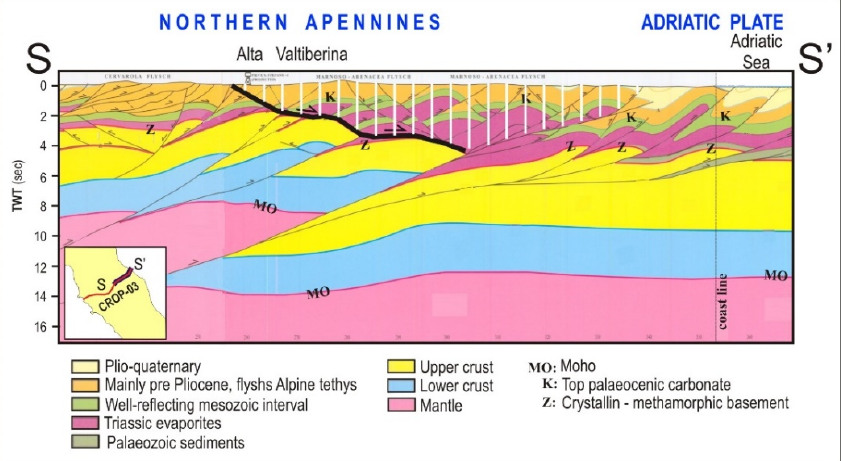
Figure 13. Eastern sector (see inset) of the CROP-03 cross-section ([41,112] modified). The white vertical strips evidence the RMU sedimentary wedge, which is decoupled from its basement by the Valtiberina fault (thick black line). This decoupling has been favored by the presence of Triassic evaporites. The eastward migration of the RMU wedge (driven by belt parallel compression) induces extension in the inner zone and thrusting at the outer front, where the wedge overthrusts the Adriatic domain (see text for explanations).